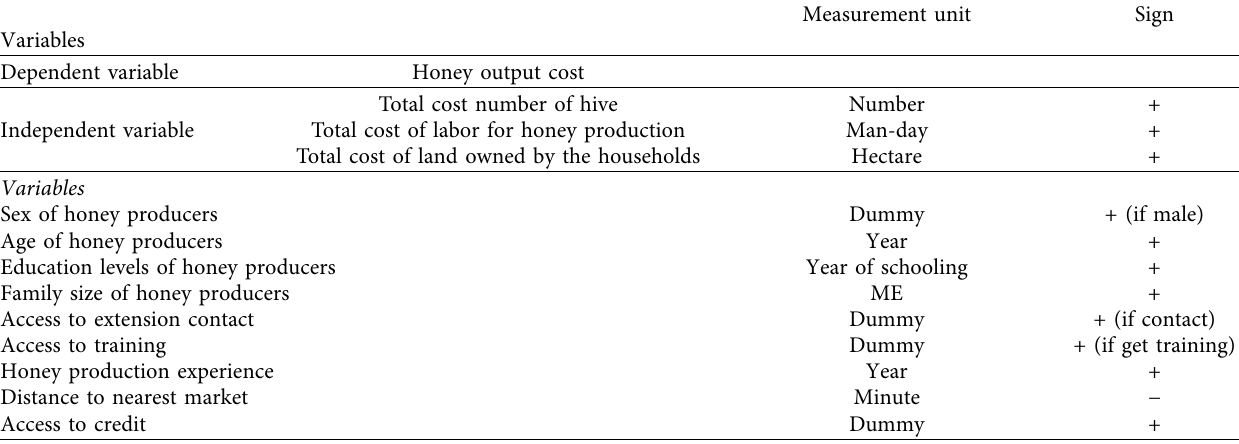
Table 1: Expected sign of variables.